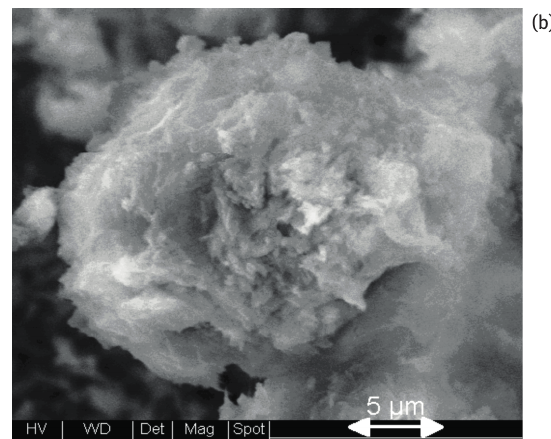
Figure 2: SEM image of NPK 110 fertilizer (d